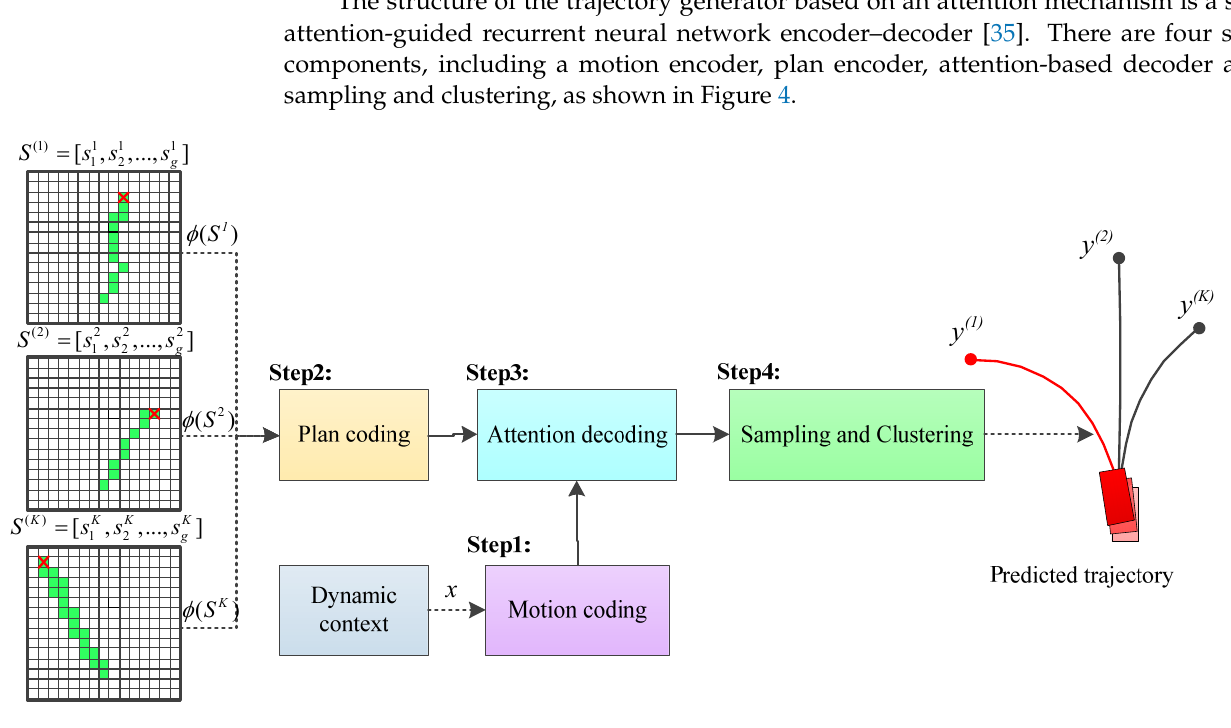
Figure 4. Attention ‐ based trajectory generator. Figure 4. Attention-based trajectory For the first step, the motion encoder can utilize a gate recurrent unit (GRU) encoder to encode the track history x , which is a snippet of the SDV’s nearest track history with time T h .